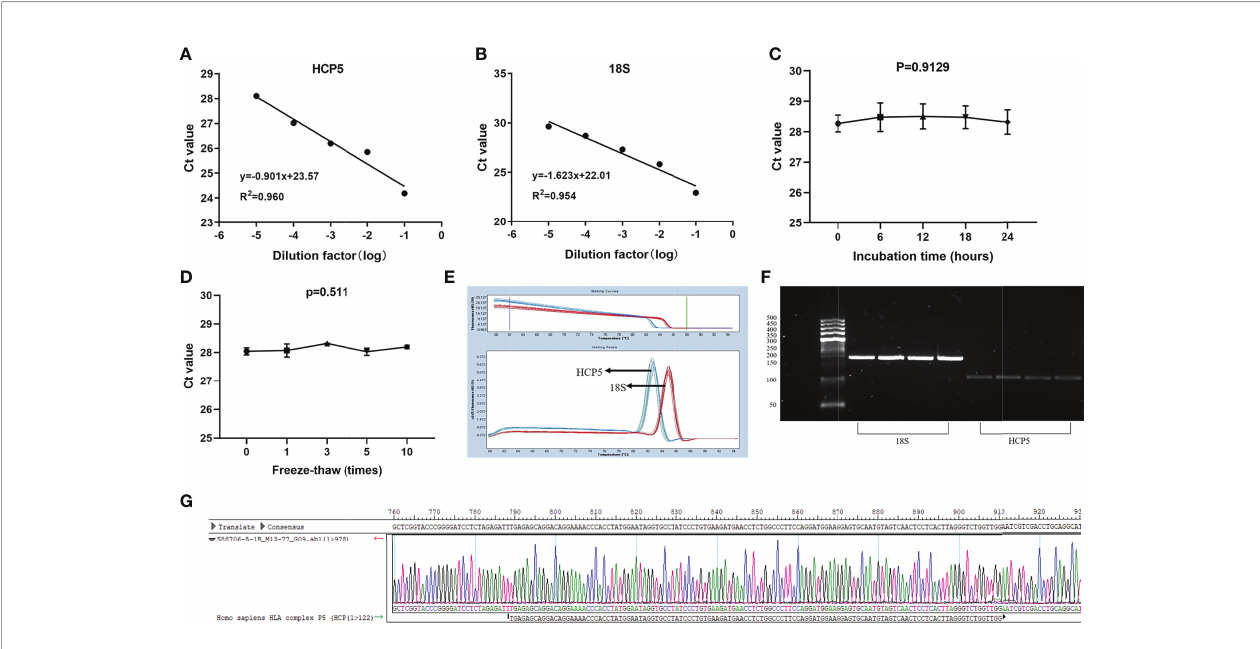
FIGURE 1 | Methodology evaluation of HCP5 in GC serum samples. (A, B) Standard curves of serum HCP5 and 18S in a ten-fold serial dilution to show the linearity. (C, D) Stability of HCP5 under room temperature incubation time or multiple freeze-thaw cycles. Data were presented as raw Ct value (n=3). (E) The speci fi city of PCR products by the melting curve. (F) The validation of PCR products by the agarose gel electrophoresis. (G) The product sequence was veri fi ed by Sanger